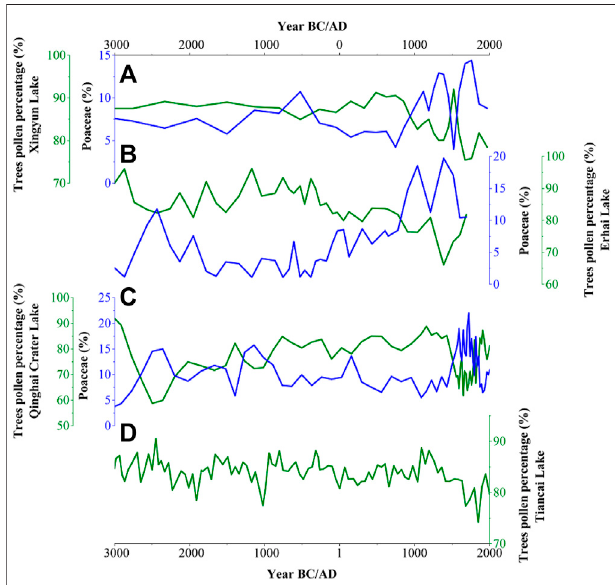
FIGURE4| SummaryofpollendataforancientYunnan(Greenlines:tree pollen percentage; Blue lines: poaceae pollen percentage; data source: Shen et al. (2006); Chen et al. (2014); Xiao et al. (2014); Wu et al. (2015); Xiao et al. (2015)).